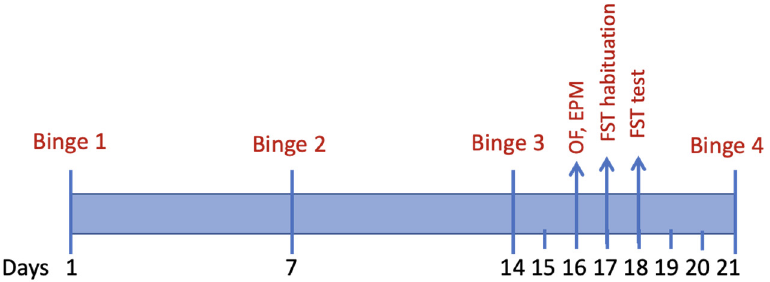
Figure 1. Timeline of experimental manipulations. Forty-eight hours after the third binge, rats were behaviorally tested for the next three days.